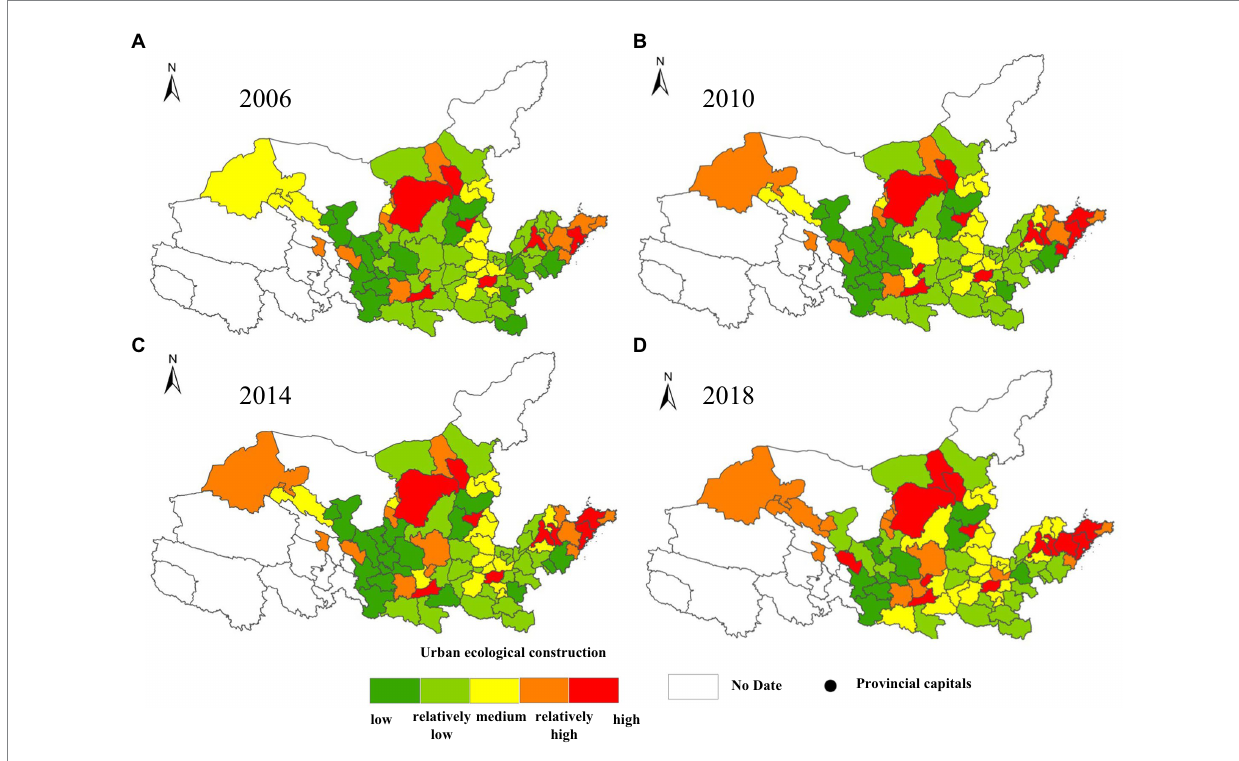
FIGURE 3 Spatial distribution of quality of urban ecological construction in the Yellow River